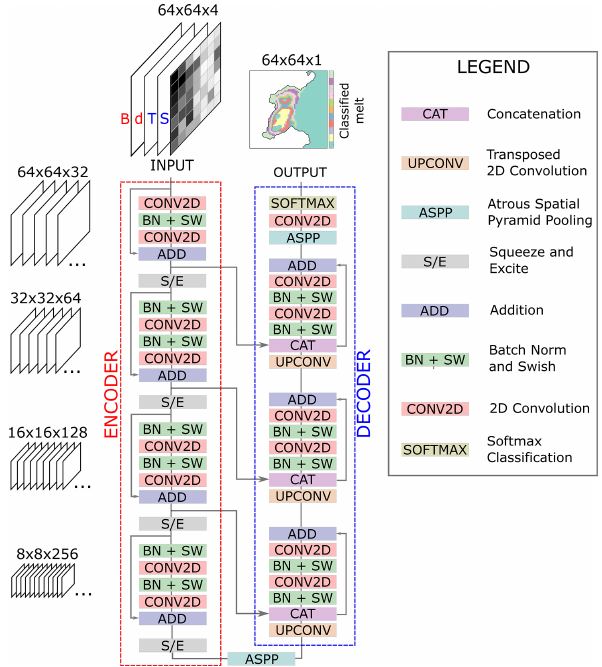
Figure B1. Schematic for the segmentation network used in this study. An input 64 × 64 × 4 image goes through layers of 2D con- volutions, batch normalisations, and swish layers through the de- coding and encoding branches. Once trained on NEMO results, the final output is a segmented image consisting of melt rate labels that can then be converted into a melt rate field using the DAE